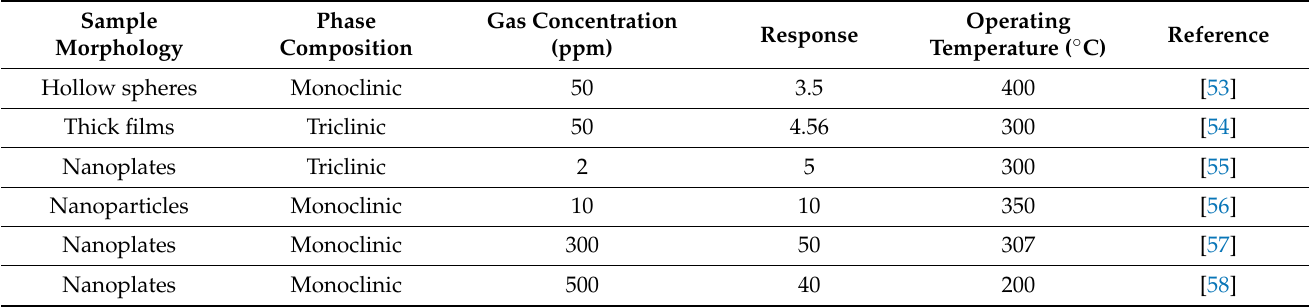
Table 2. Summary of the main features of the WO 3 -based acetone sensors described in Section